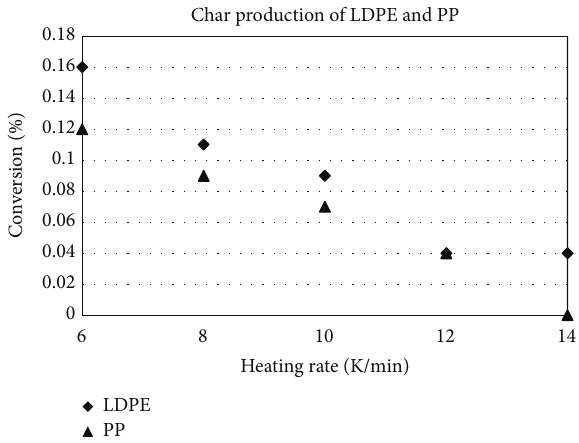
Figure 4: The effect of temperature increasing rate on solid product of each plastic compound.